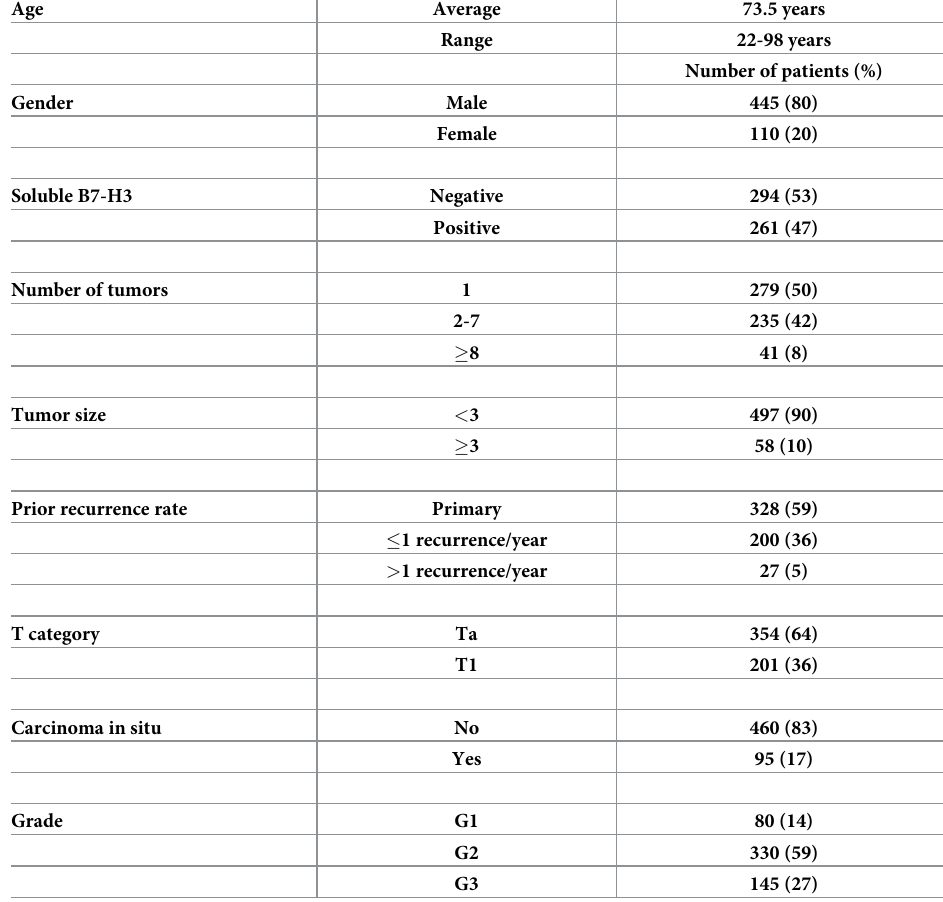
Table 1. Characteristics of patients with